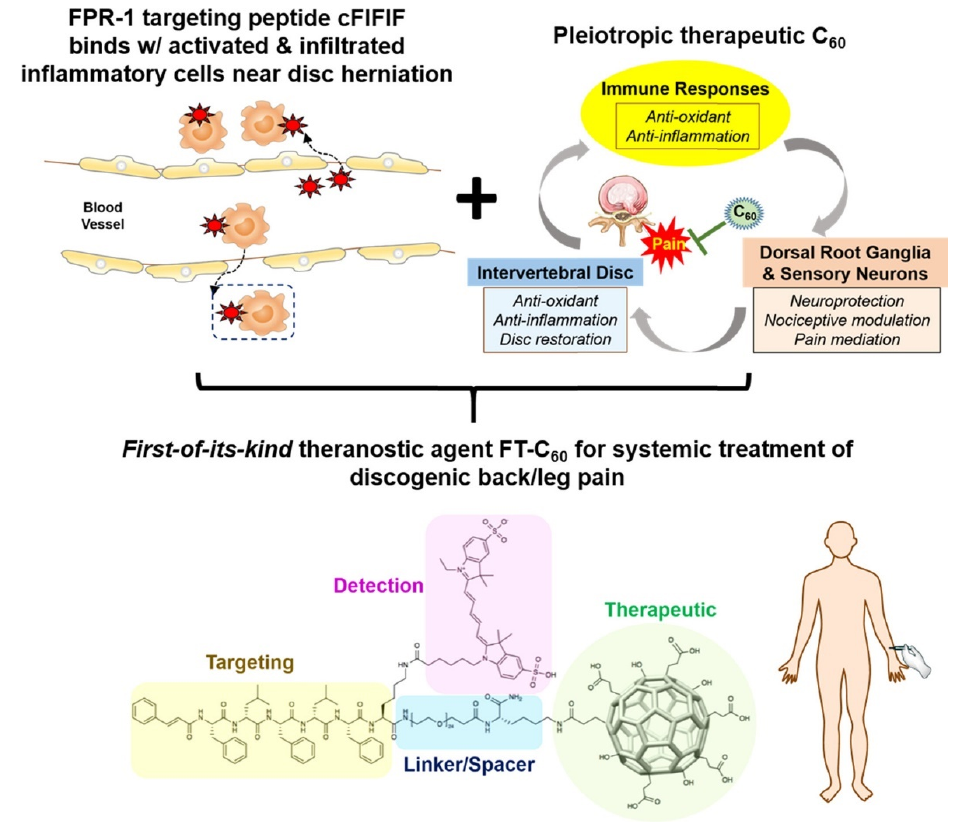
Figure 3. Schematic illustration of the therapeutic and targeting mechanism of the FIFIFK-functionalized C 60 to treat discogenic pain. Reprinted with permission from [160]. Copyright © 2022, American Chemical Society.